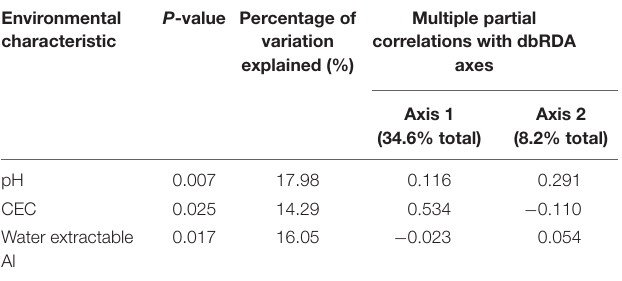
TABLE 2 | Results of distance-based multivariate multiple regression (DistLM) based on Bray-Curtis dissimilarities for microbial community structures and measured geochemical variables, using 9,999 permutations under a forward selection procedure with Bayesian Information Criterion as selection criterion. Environmental